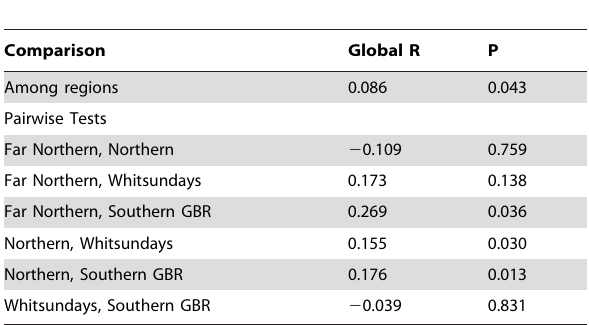
Table 1. Output of the analysis of similarity (ANOSIM) test of Symbiodinium communities sampled in each of the four regions (Far Northern, Northern, Whitsundays and Southern GBR) of the Great Barrier Reef.